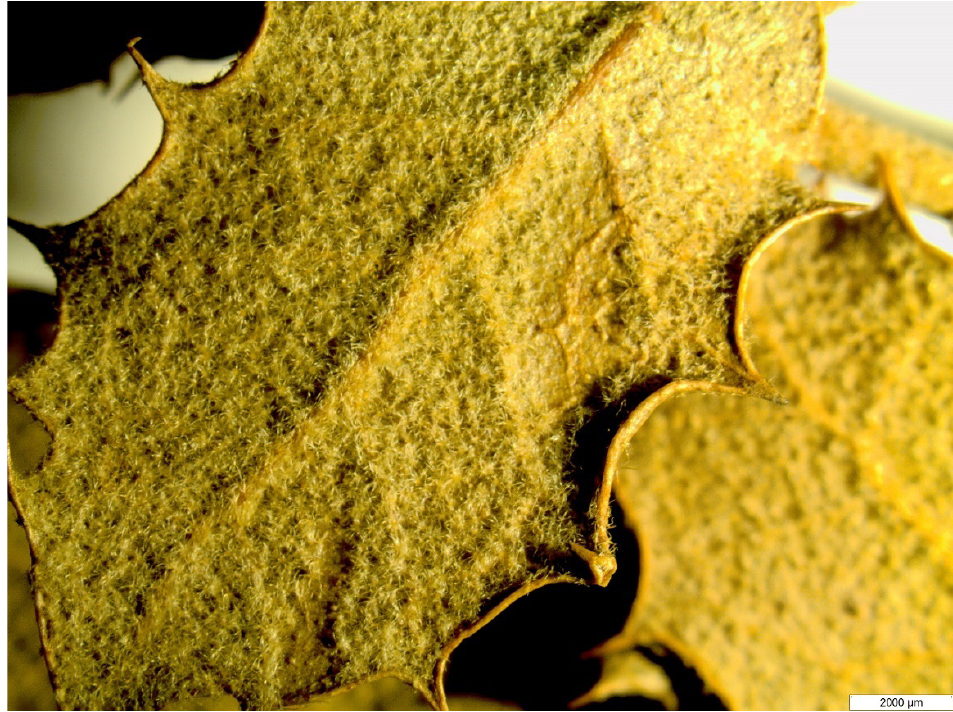
Figure 1. Fully tomentose abaxial leaf surface of Q. airensis Franco &